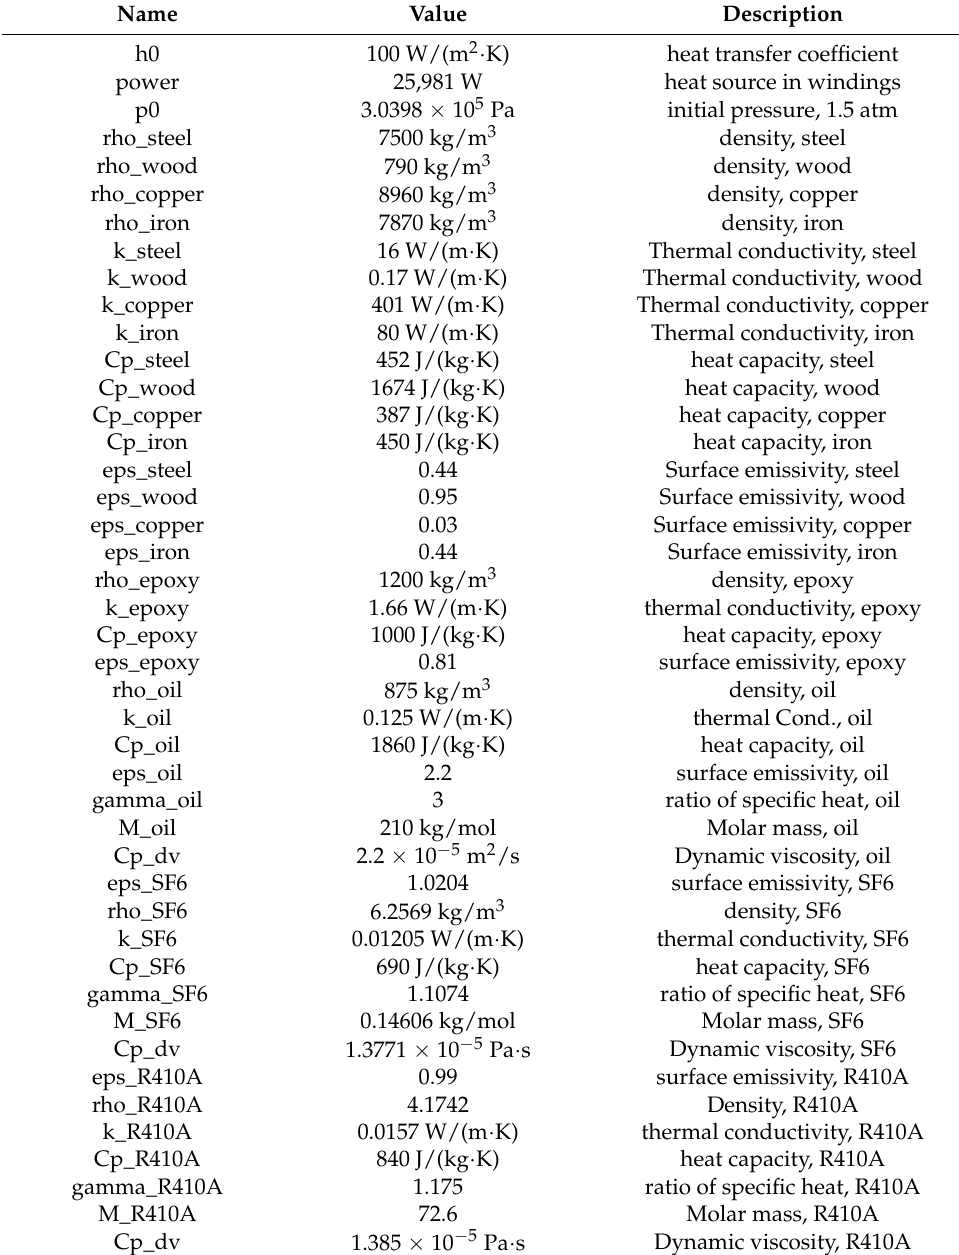
Table 5. Physical property